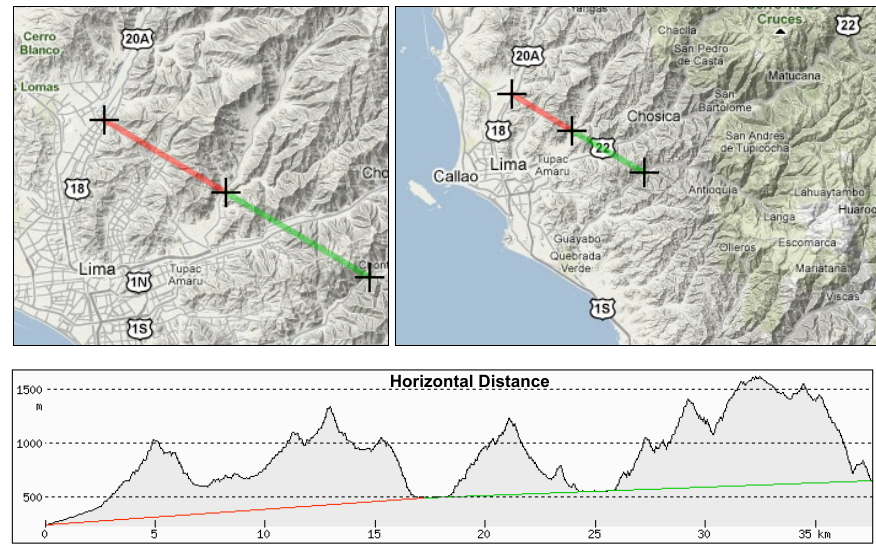
Fig. 1. Top panels show the location and topography surrounding the Jicamarca radar site in Peru, South America. The straight line passing from the northwest to the southeast cuts a height profile as shown in the lower panel, with red indicative of space to the northwest and green indicative of the southeast. The point where the red line and green line meet is the location of Jicamarca. North is towards the top of the page. [Maps from Google Earth, topology from HeyWhatsThat Path Profiler at heywhatsthat.com.] figure